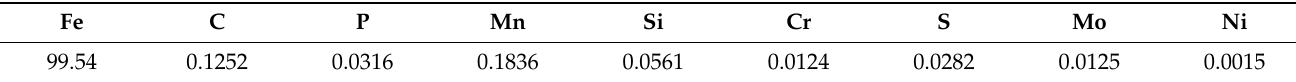
Table 1. Composition of mild steel (in